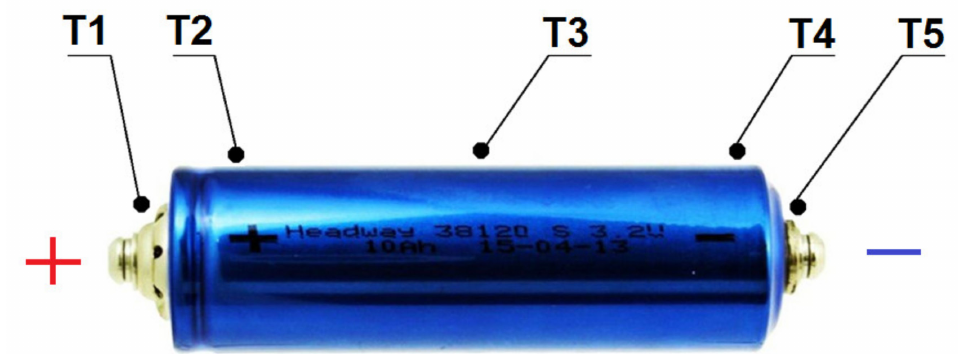
Figure 4. Arrangement of temperature sensors on the tested cell. Basic cell technical data